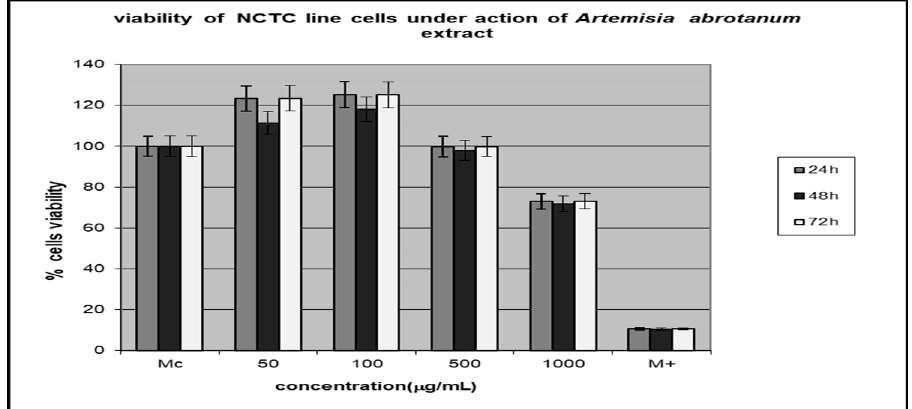
Figure 2. The viability of NCTC cell lines under the action of A. abrotanum extracts.